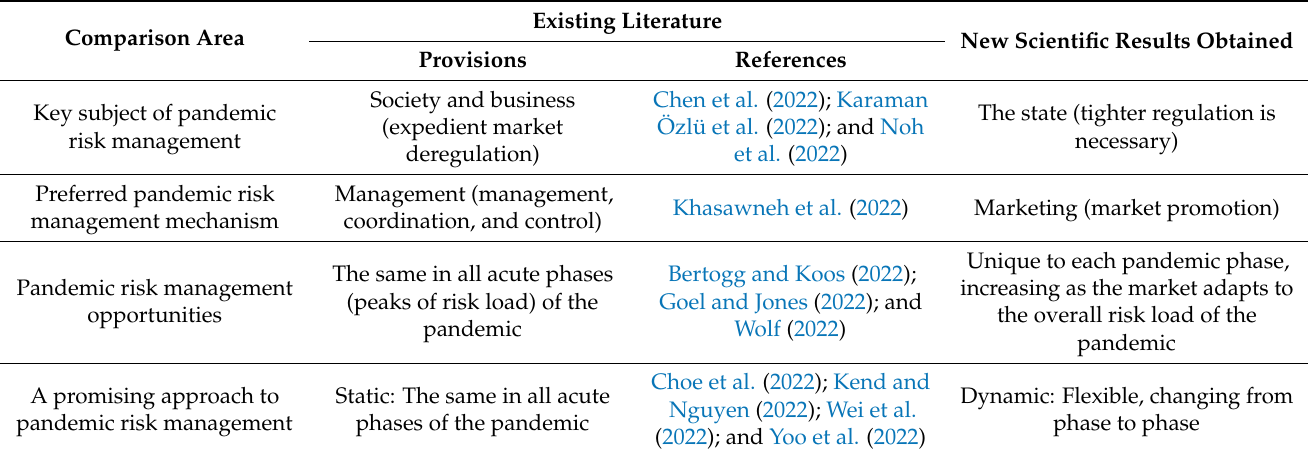
Table 1. Comparison of new scientific findings with existing